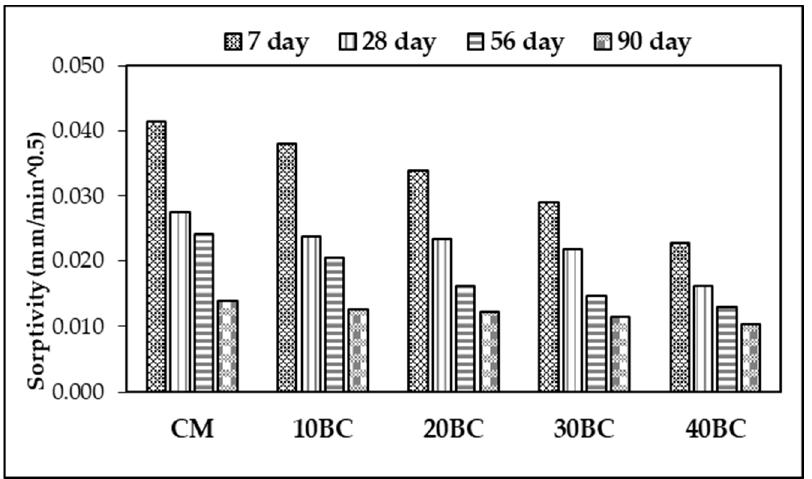
Figure 10. Sorptivity values at different replacement levels of SBA.